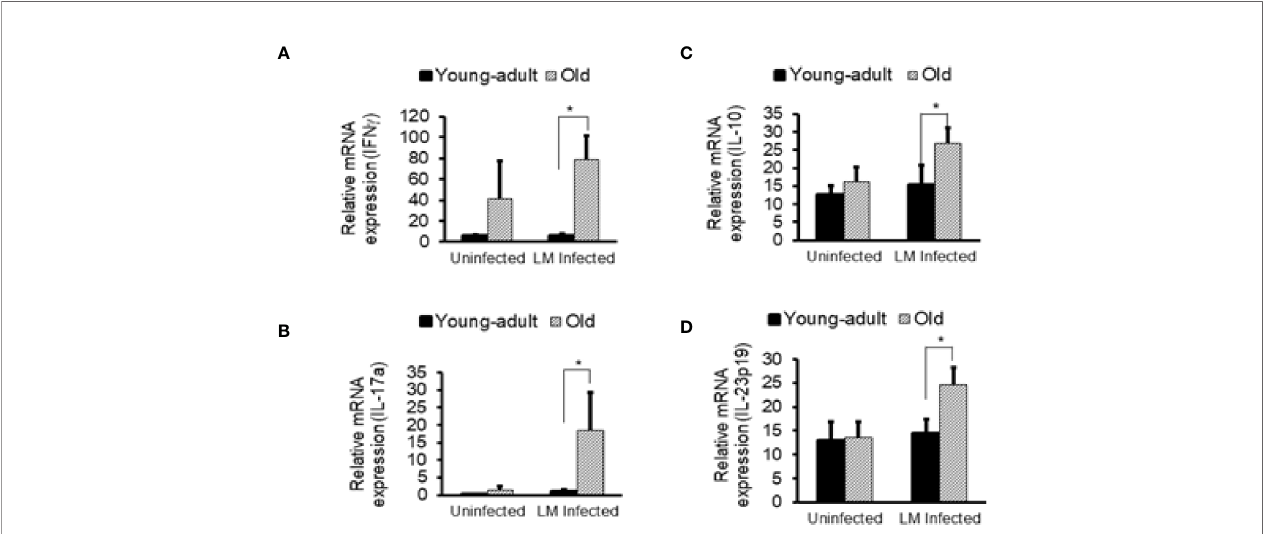
FIGURE 8 | Increased in vivo in fl ammatory cytokine mRNA responses in the intestinal tissue from Listeria monocytogenes -infected old mice. Intestinal tissues from uninfected and L. monocytogenes (Lm)-infected mice of both age groups at 7-days post infection were used for RNA extraction and IFN- g (A) , IL17a (B) , IL-10 (C) , and IL-23 (D) mRNA expression were measured. Data from mean ± SEM from a representative experiment using 4 – 6 mice. *p <